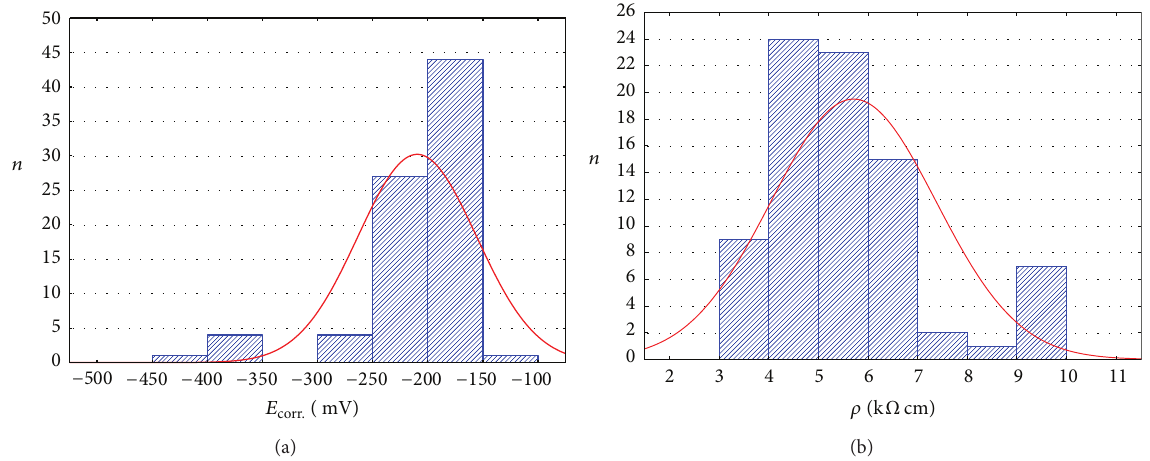
Figure 8: Histogram of (a) potential 𝐸